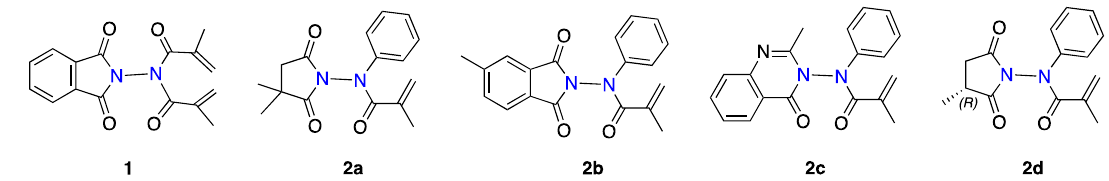
Table 1. Torsional angle ( θ ) (CO– N – N –CO) of the evaluated hydrazides a .